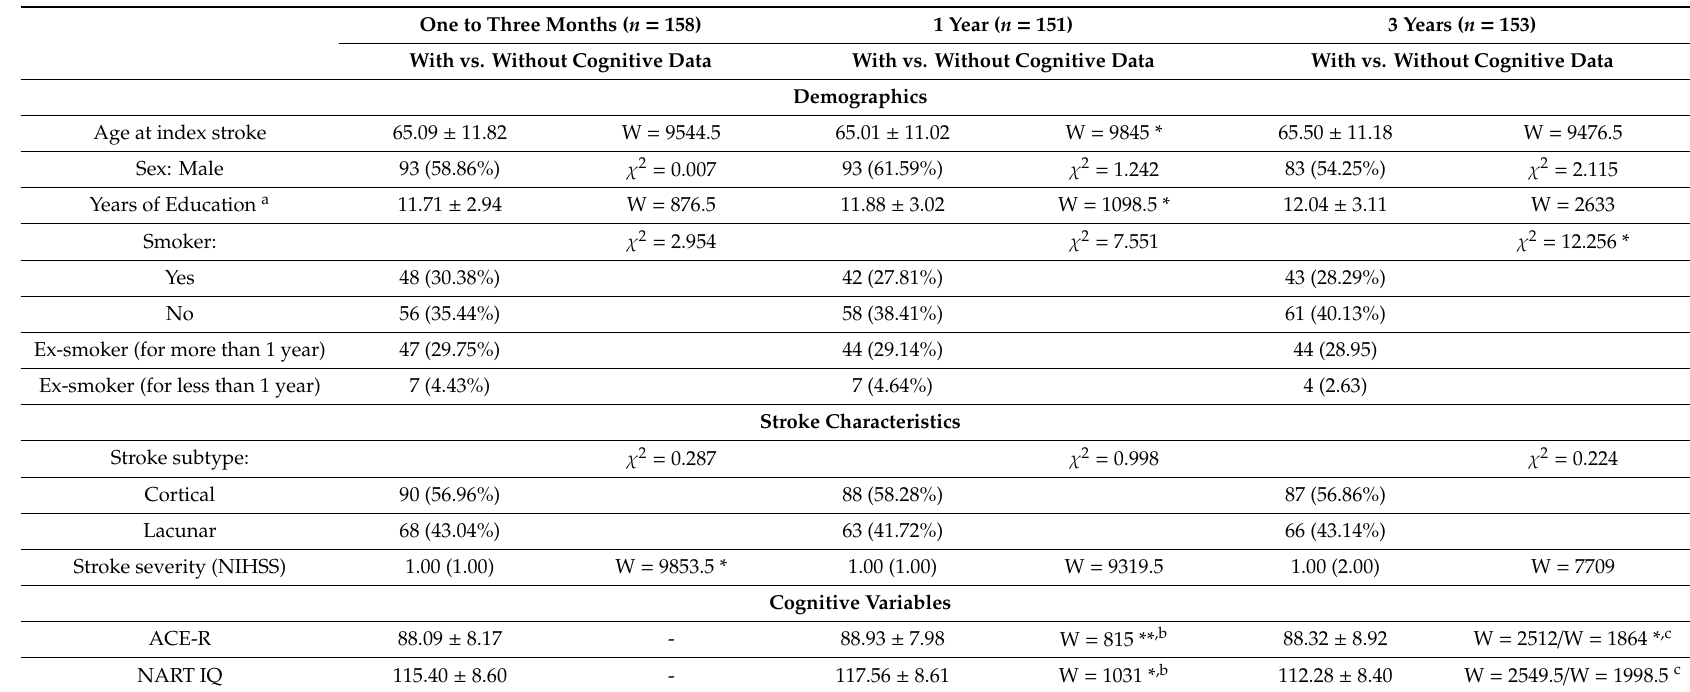
Table 1. Baseline characteristics of patients with cognitive data by